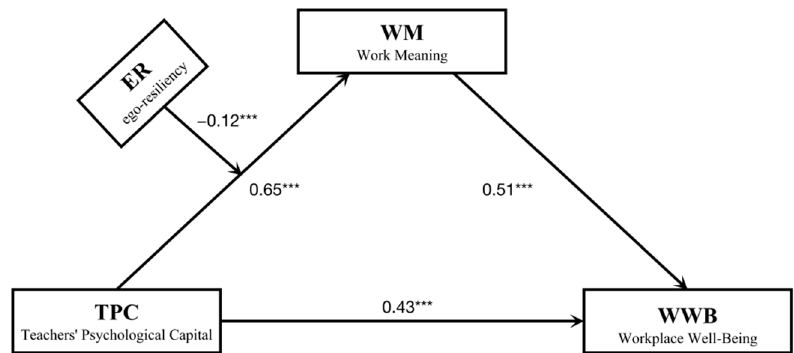
Figure 3. The moderated mediation model of four main variables. *** p < 0.001.